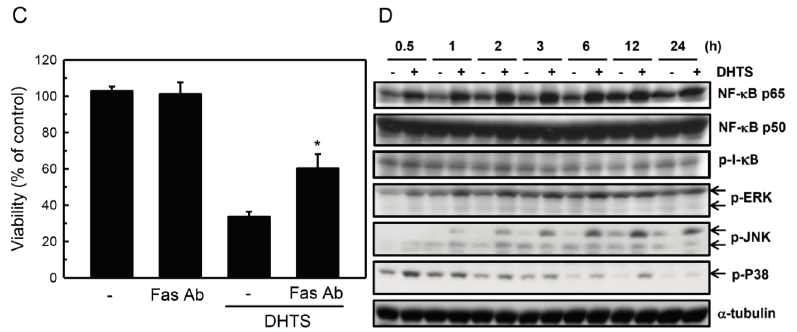
Figure 4. Effects of 15,16-dihydrotanshinone I (DHTS) on FasL and nuclear factor (NF)- κ B expressions and mitogen-activated protein kinase (MAPK) phosphorylation in human HL-60 promyelocytic leukemia cells. ( A , B ) Cells were treated with various concentrations of DHTS for 24 h or 1.5 μ g/mL DHTS for different time periods. ( A ) Total RNA was collected to determine FasL mRNA expression by an RT-PCR; ( B ) Total cellular proteins were collected to determine FasL protein expression by Western blotting; ( C ) Cells were treated with 1.0 μ g/mL DHTS and 10 μ g/mL anti-Fas blocking antibody for 24 h. Viable cell numbers were measured by an MTT assay. Data are expressed as the mean ± S.D. of three independent experiments. * p < 0.05, compared to the column 3; and ( D ) Cells were treated with 1.5 μ g/mL DHTS for different time periods. Total cellular proteins were collected to determine protein expressions by Western blotting. p-ERK, phosphorylated extracellular signal-regulated kinase; p-JNK, phosphorylated c-Jun N-terminal kinase; p-p38, phosphorylated p38.